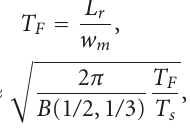
where g 1 = 0 . 4 and g 2 = 0 . 25. T f and K F are defined as